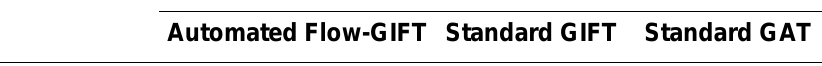
Serial Dilutions of Sera Containing Specific Human IgG Against HNA-1a, -1b, -and -3a Specific Antibodies Titer Automated Flow-GIFT Standard GIFT Standard GAT